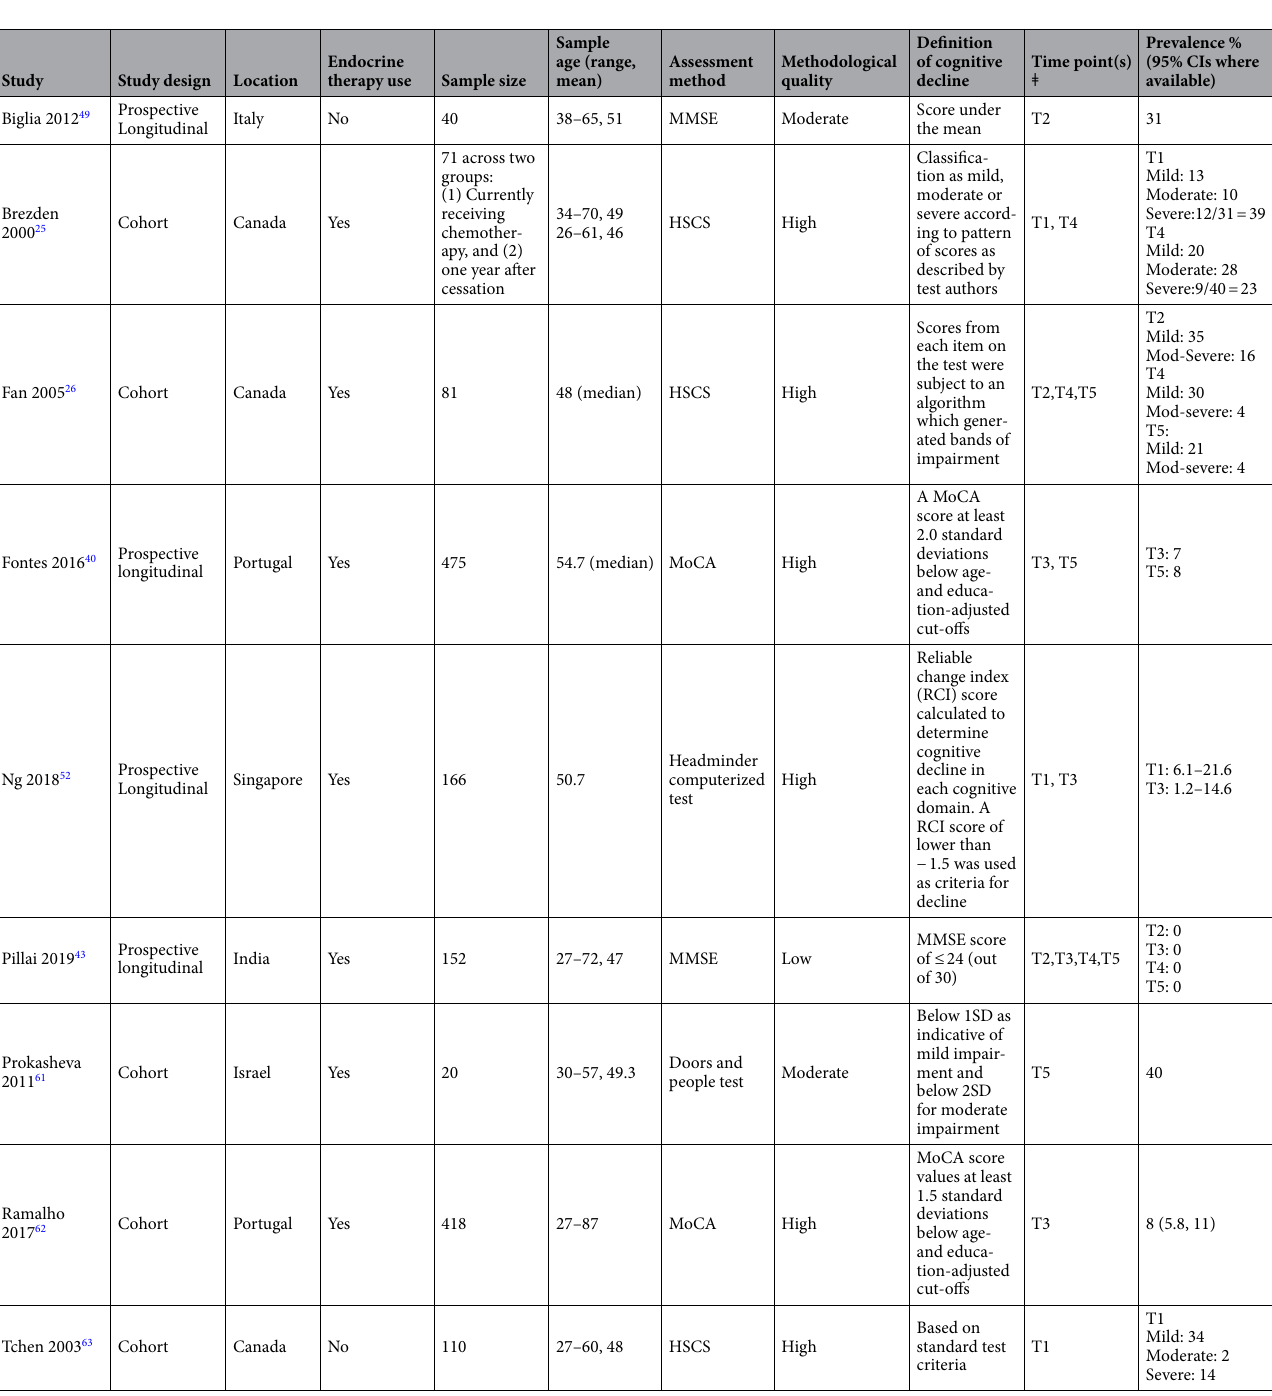
Table 2. Summary of included studies employing short cognitive screening tools to assess cognitive